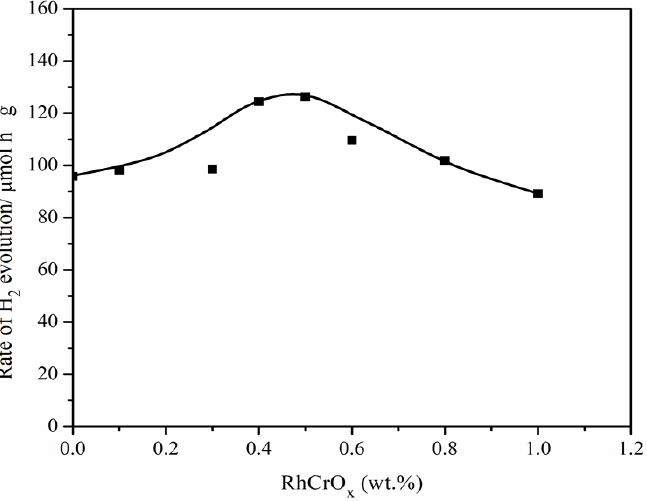
Figure 8. Photocatalytic H 2 performance of Pr-LaFeO 3 photocatalysts modified with different amounts of Rh and Cr cocatalyst.